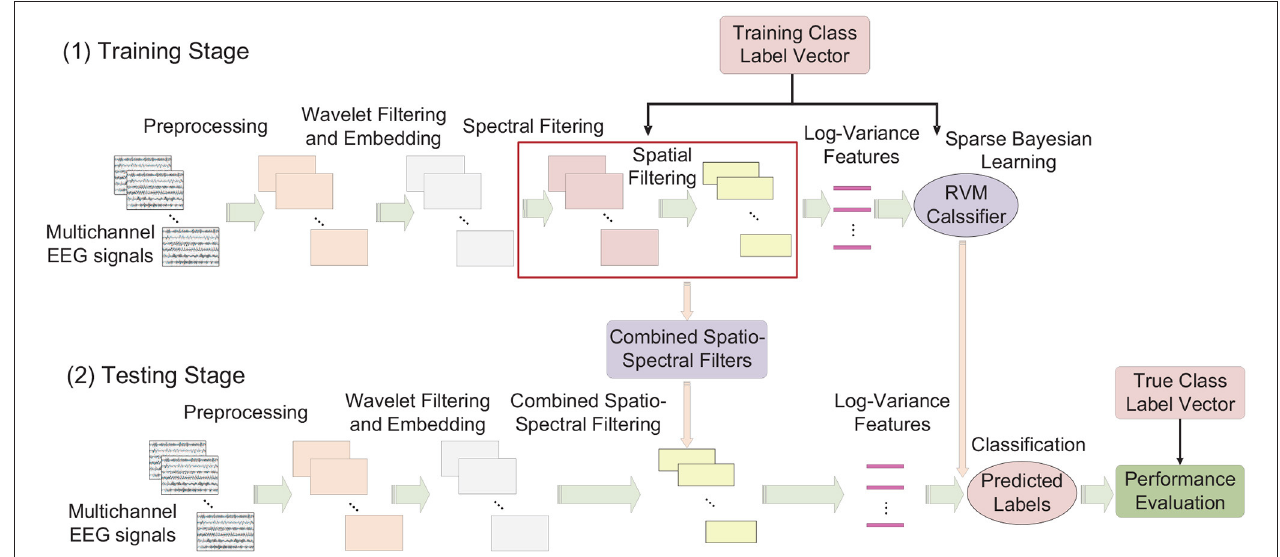
T . Note that the dimensions of a × T , M T , C T , and 2 m T , × × × ×